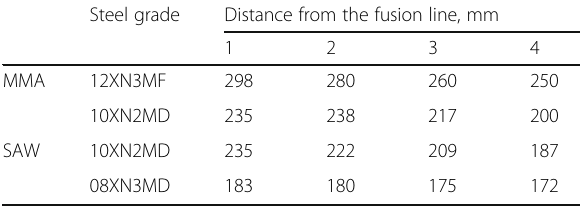
Table 9 Hardness of HAZ in welds by MMA and